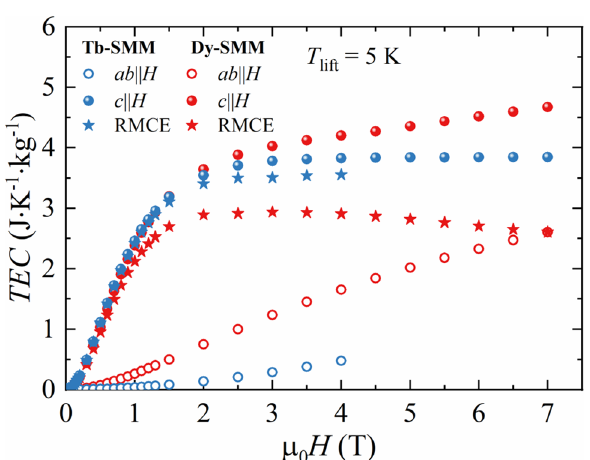
Figure 8. The temperature averaged entropy change (TEC) in the function of applied magnetic field µ 0 H calculated for temperature interval Δ T lift = 5 K for conventional MCE and RMCE for Tb-SMM and Dy-SMM